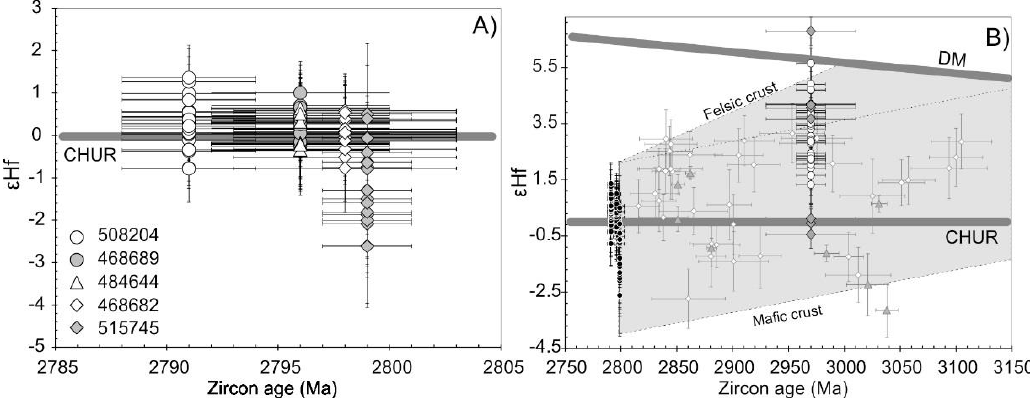
Figure 8. Zircon εHf versus age diagram. ( A ) Each sample display limited Hf isotope variations, only sample 515745 mix toward a less radiogenic Hf isotope composition. ( B ) IIC data are plotted together with zircon data from regional Mesoarchaean TTG gneisses (shaded triangles) and detrital zircon (white squared) [16] and zircon data from Fiskenæsset complex and whr. Lu-Hf data from meta-volcanic and supracrustal belts [24,41]. The shaded grey area represents the possible source region of IIC from a felsic and mafic crust, our preferred interpretation is a mafic source region.